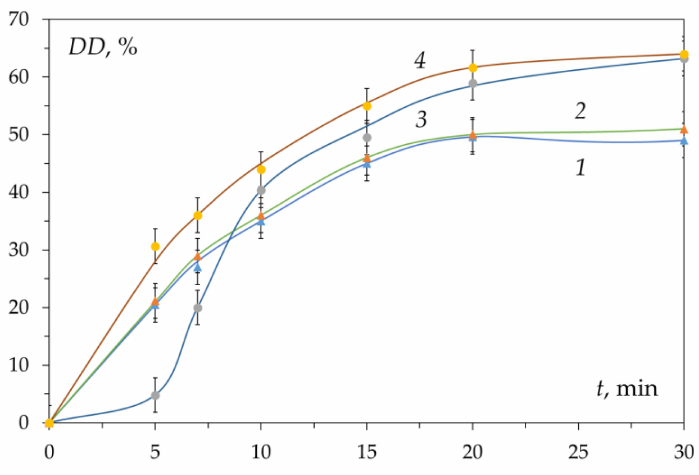
Figure 9. Kinetic curves of deacetylation of chitin samples in 50% NaOH at (95 ± 1) ◦ C: initial chitin dried in air (1) and in a freeze dryer (2); reprecipitated chitin dried in air (3) and in a freeze dryer (4). Original